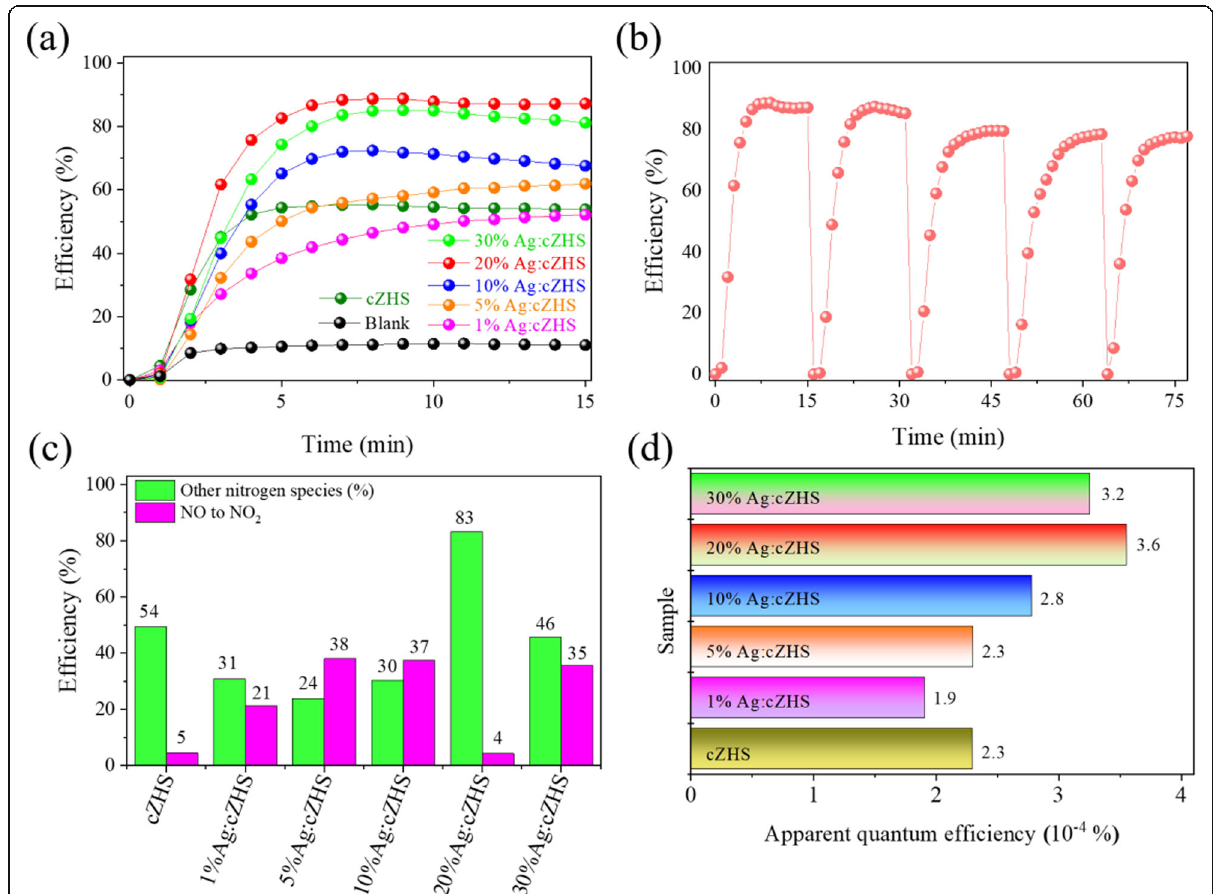
Fig. 2 The photocatalytic activity ( a ), the recycling test ( b ), NO conversion ( c ), apparent quantum efficiency ( d ) of the materials after 15